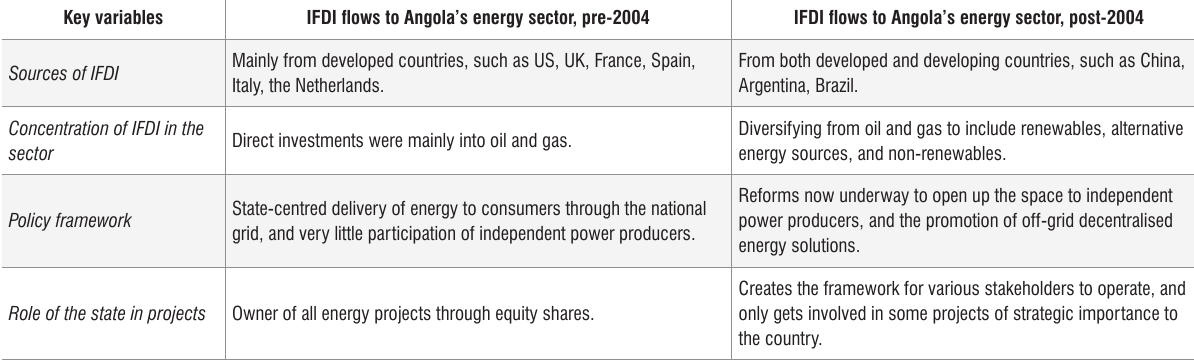
Differences in inward foreign direct investment to the energy sector, before and after